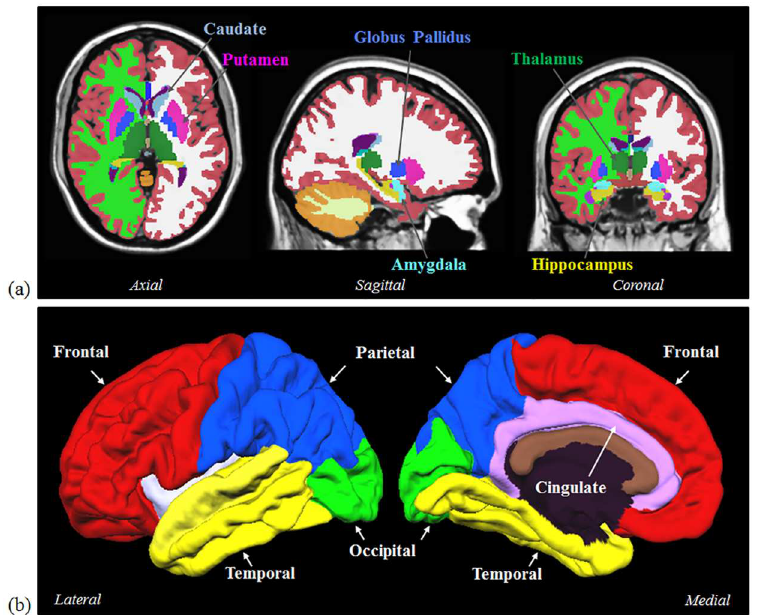
Fig 1. (a) Six subcorticalstructures includingcaudate, putamen, globuspallidus,hippocampus, amygdala, and thalamuswere selectedas ROIs. (b) Five cerebral cortical regions including frontal, parietal, occipital, temporal, and cingulatewere also selectedas